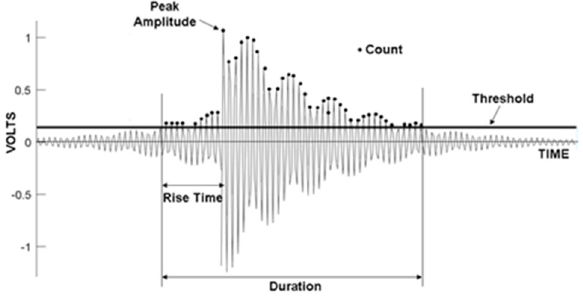
Figure 2. Traditional AE features.